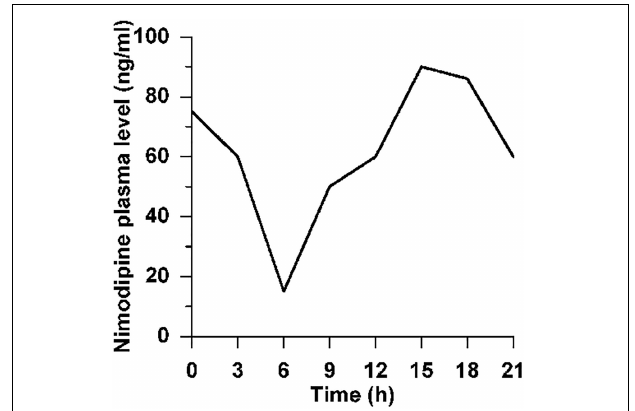
FIGURE 2 | Circadian plasma level of nimodipine. Circadian plasma level of nimodipine after feeding of normal female Wistar rats ad libitum with 1,000 ppm nimodipine for 2 weeks. Animals were kept under artificial light at 0600–1800 h, in the dark 1800–0600 h. N = 4 rats per time point, hence no SD is